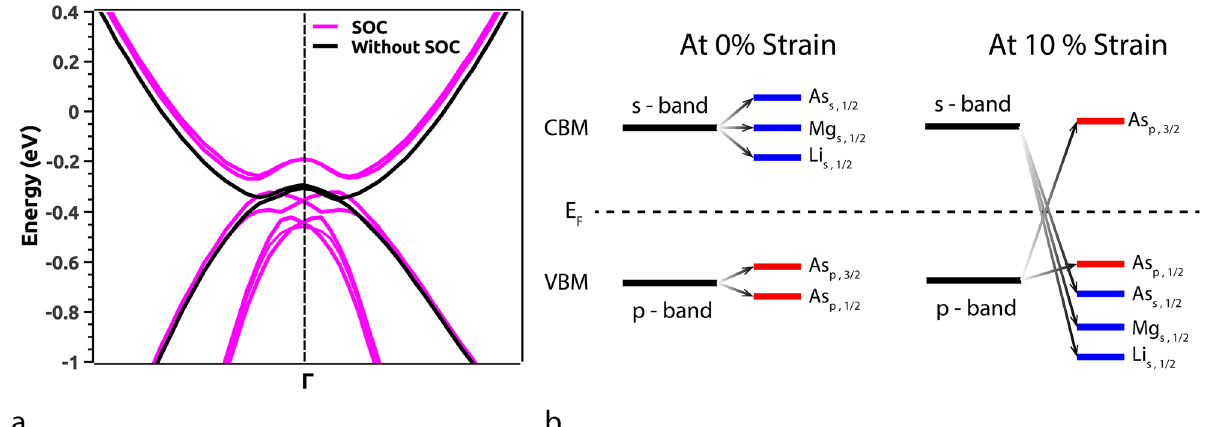
Figure 6. ( a ) Electronic Band Structure (EBS) of [111] LiMgAs without and with SOC indicating a strong band inversion at 10% compressive strain. ( b ) Orbital mechanism of band inversion in [111] LiMgAs due to SOC at 0% and 10% strain.